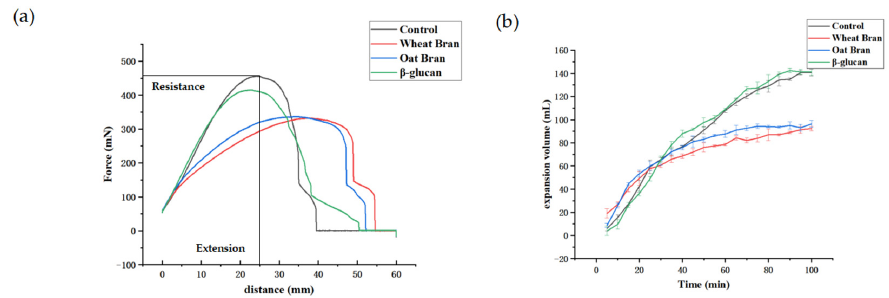
Figure 1. Effects of different additives on the tensile properties ( a ) and expansion curves ( b ) of the dough.